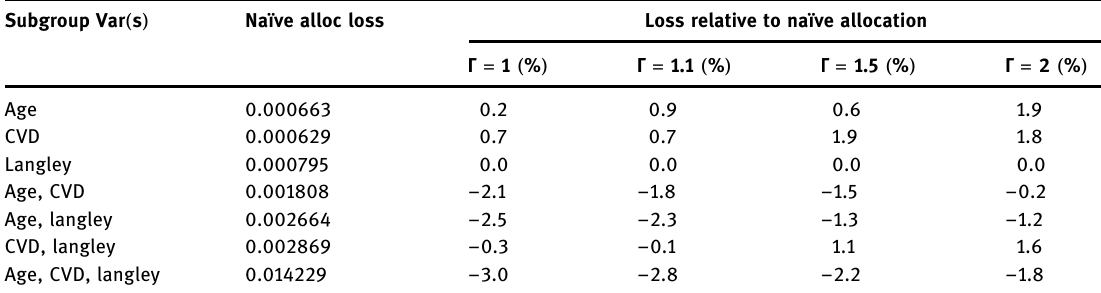
Table A11: L 2 loss comparisons for regret - minimizing allocations versus naïve allocation, rectangular con fi dence